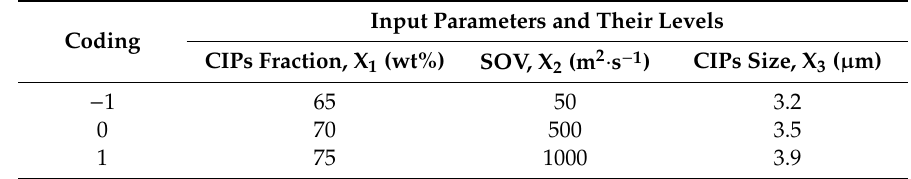
Table 1. Input parameters and their levels. CIPs—carbonyl iron particles; SOV—silicone oil viscosity.